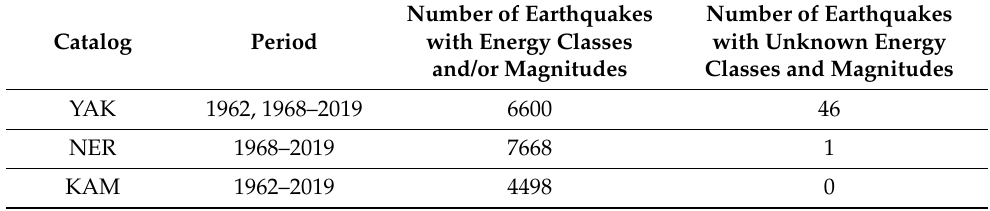
Figure 1. Studied region. The circles are the earthquake epicenters from the YAK (black), NER (red), and KAM (blue) catalogs. Table 1. Data of Russian agencies.